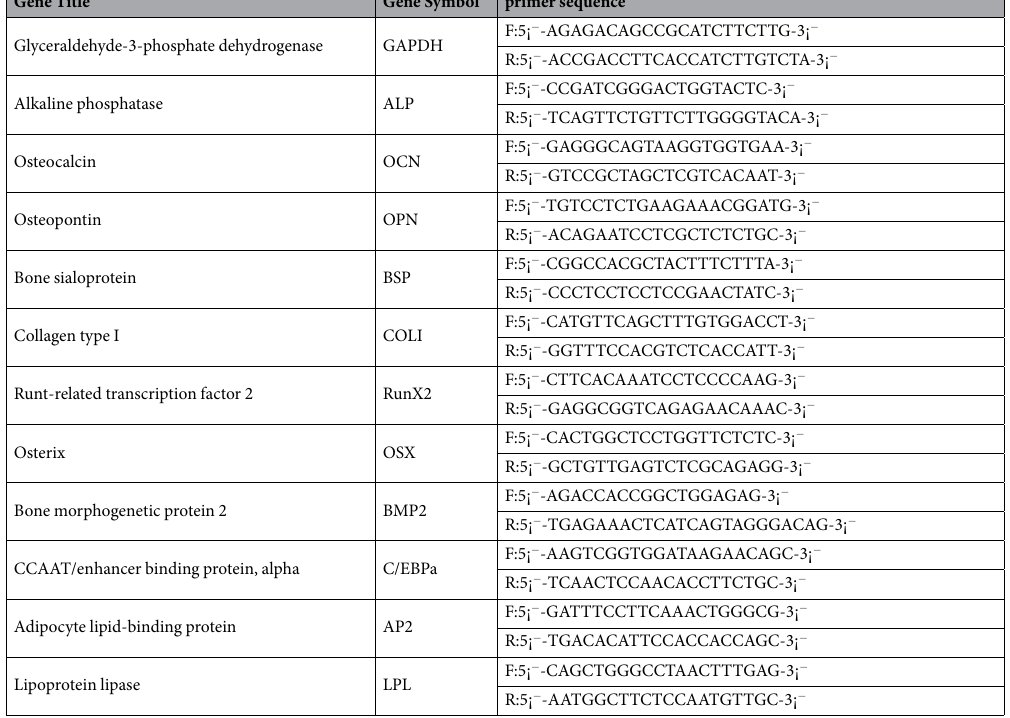
Table 3. Primer sequences used for qPCR